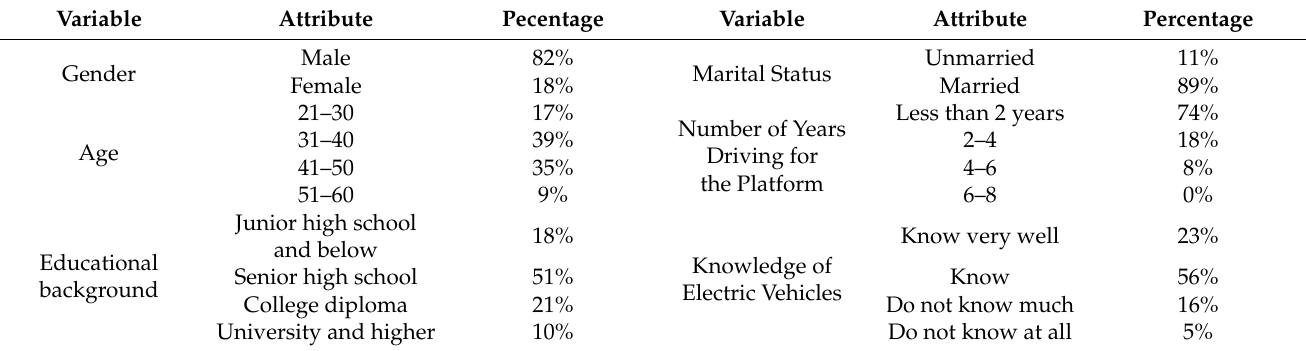
Table 6. Statistics of responding Didi